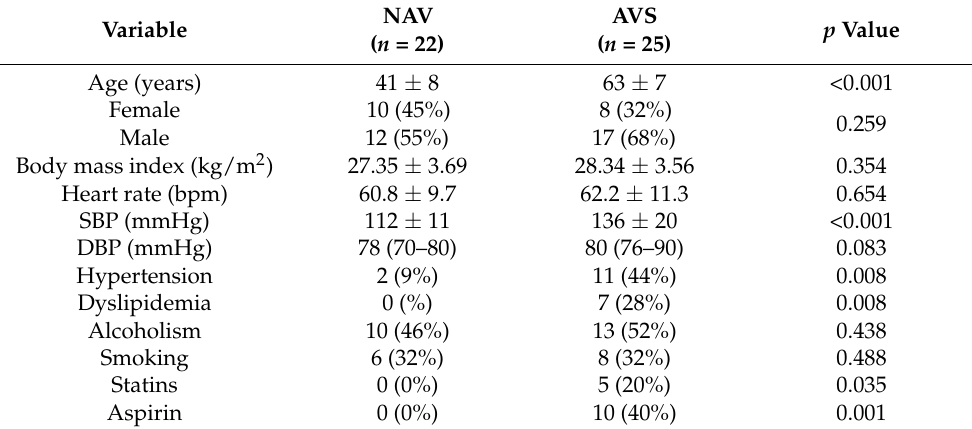
Table 1. Characteristics and risk factors of participants. Data are shown as absolute value (percentage), mean ± standard deviation, or median (percentile 25–percentile 75).